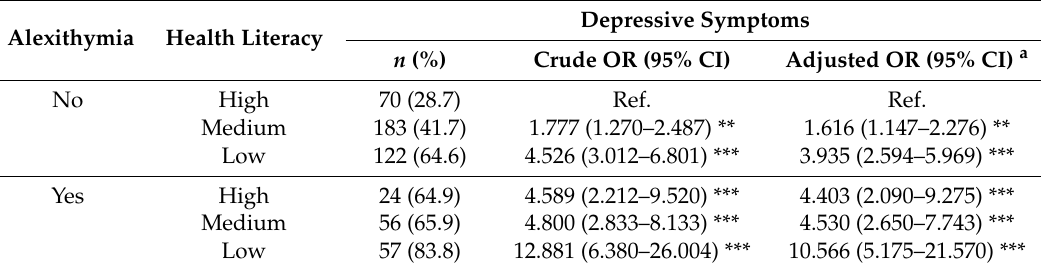
Table 3. The moderating role of health literacy on the association between alexithymia and depressive symptoms in the